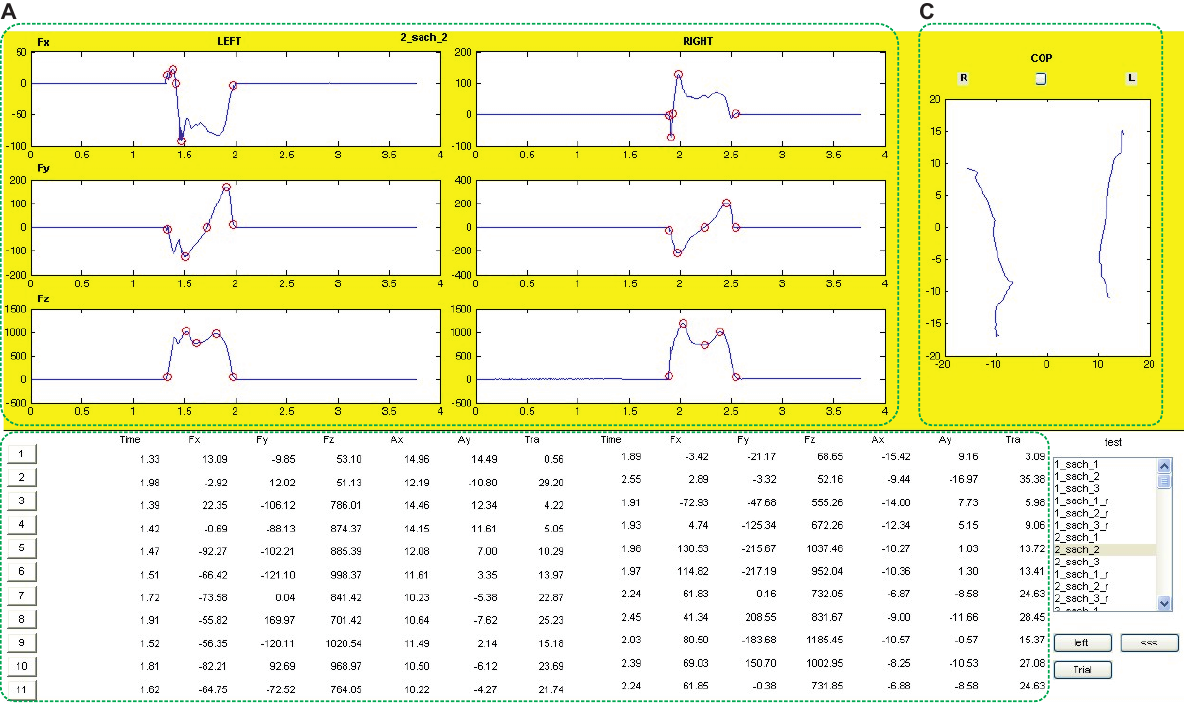
Figure 3. Gait analysis, first analysis output. Fx, Fy and Fz force-time curves of two steps (A); values of time, force and COP position at 11 defined points (B, see Figure 1A); trajectory of the COP on a force plate (C). LEFT, L = left lower extremity; RIGHT, R = right lower extremity.